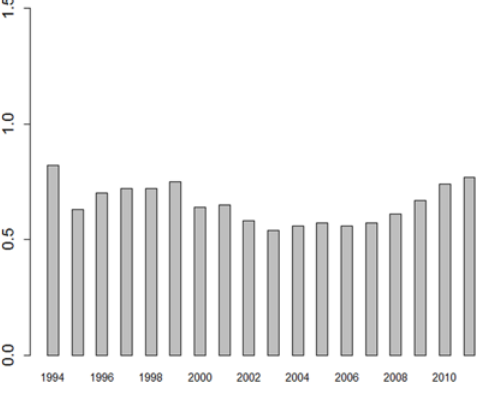
Fig 4. Ratio of R&D expenditures in percent of